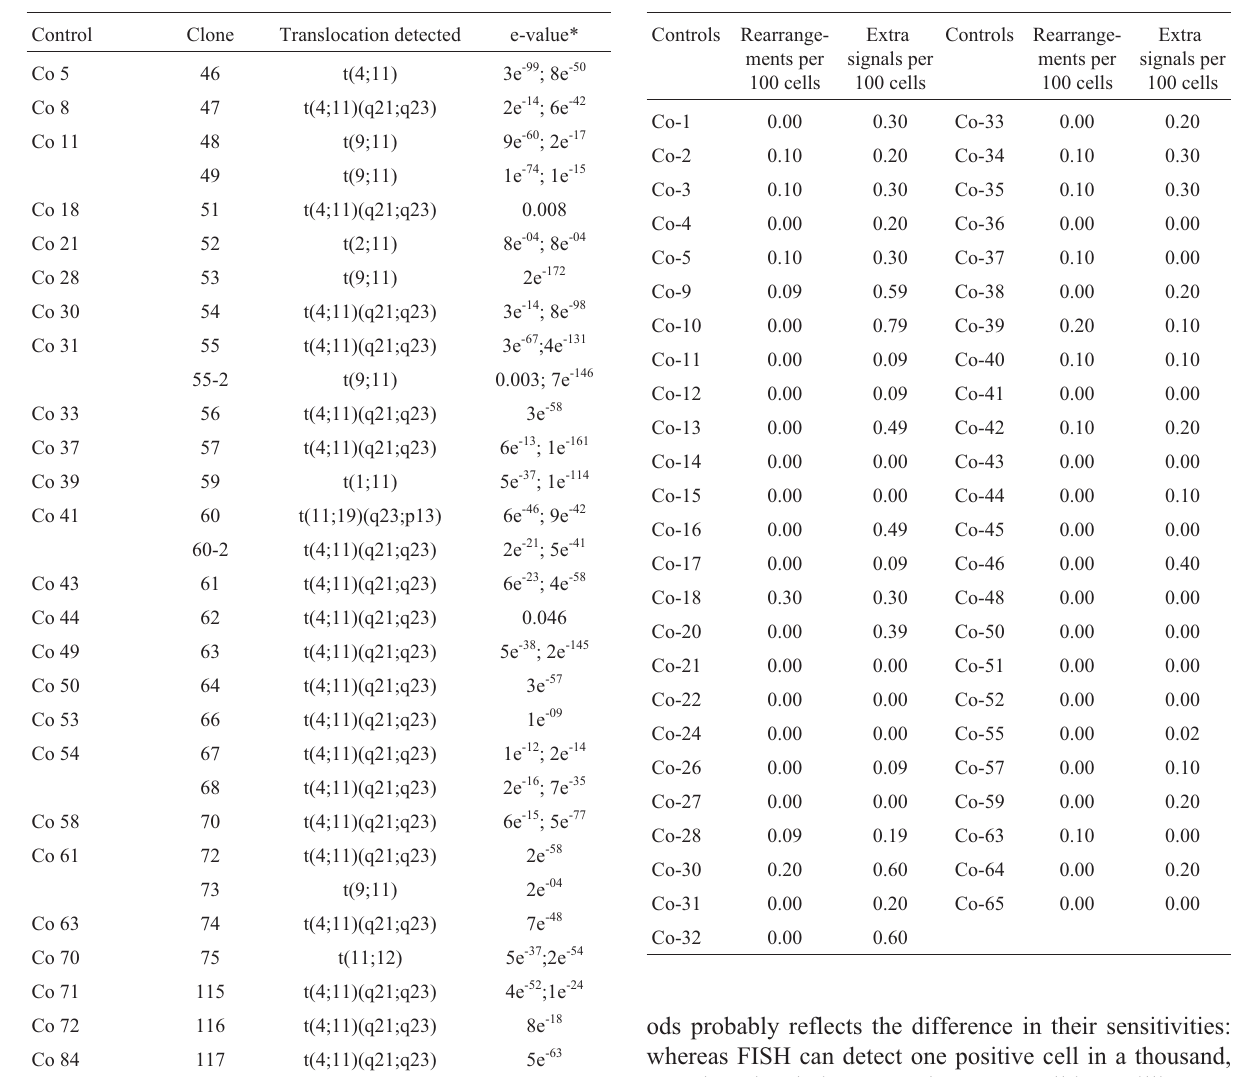
Table 1 - MLL fusions detected by inverse PCR in peripheral blood lym- phocytes from healthy individuals.